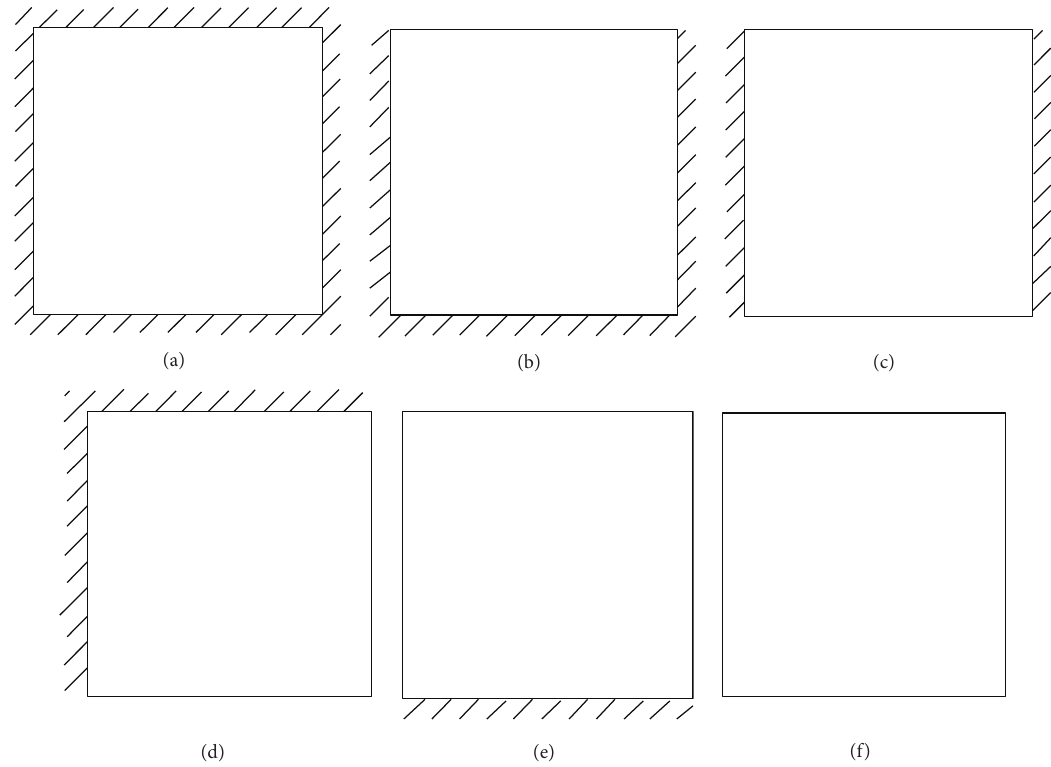
Figure 16: Sketch under different boundary conditions: (a) four edges are clamped, (b) three edges clamped and one edge simply supported, (c) opposite edges clamped and others simply supported, (d) adjacent edges clamped and others simply supported, (e) three edges simply supported and one clamped, and (f) four edges simply